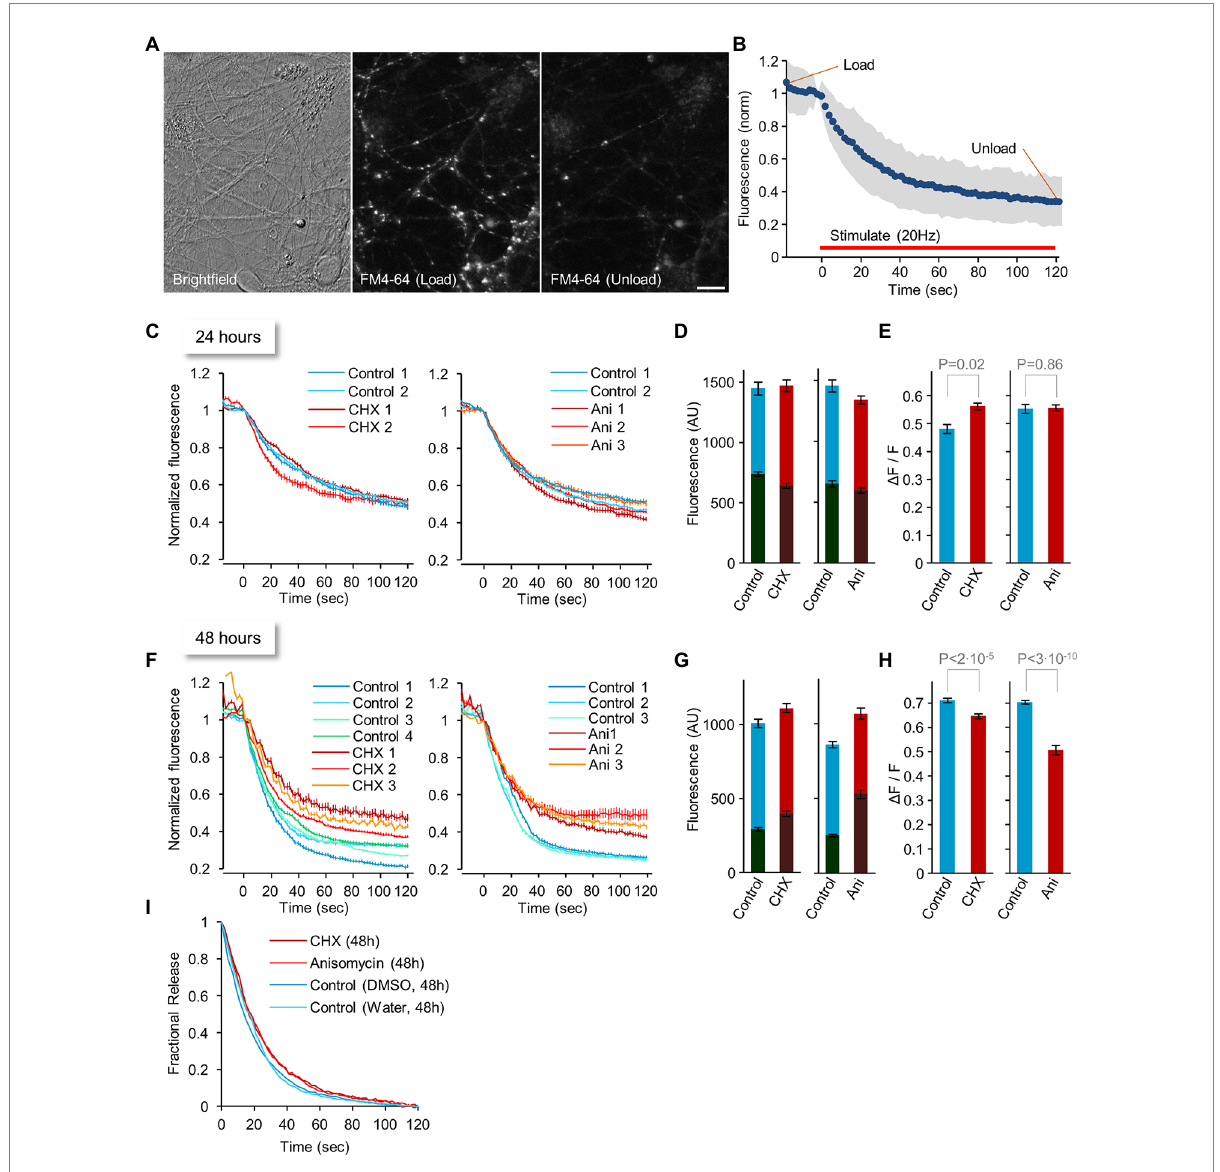
FIGURE 4 Changes in synaptic vesicle recycling after 24 or 48 hours of protein synthesis inhibition. (A) Images of FM4-64 labeling at structures that most likely represent functionally active presynaptic boutons (left: brightfield image, middle: FM4-64 dye after loading, right: dye after unloading). Bar, 10 μ m. (B) Experimental procedure: 2–2.5-week-old neuronal networks were loaded with FM4-64 by field stimulation. Images as in (A) were obtained at several fields of view. Dye unloading was carried out by field stimulation (20 Hz, 120 sec.; red line) while imaging at 2 sec intervals at one field of view. After dye unloading was completed, a second image of all other fields of view was acquired. Dye loading and unloading (measures of endocytosis and exocytosis) were quantified for individual presynaptic boutons at each field of view by measuring the FM4-64 fluorescence of presynaptic puncta after loading, and after unloading. For fields of view imaged during the unloading procedure, the fluorescence of each bouton was normalized to its fluorescence intensity before dye unloading, and normalized data were pooled to create release curves (in blue; standard deviation is marked in gray). For all other fields of view, the fluorescence of each bouton was quantified at two time points (“Load” and “Unload”), followed by a calculation of the fraction of dye released by the unloading stimuli. (C–E) Changes in synaptic vesicle recycling after 24 h of protein synthesis inhibitor treatment: Dye release curves (C) , Absolute fluorescence after loading and unloading (D) , and Fractional dye release (E) . (F–I) changes in synaptic vesicle recycling after 48 hours of protein synthesis inhibitor treatment: Dye release curves (F) ,